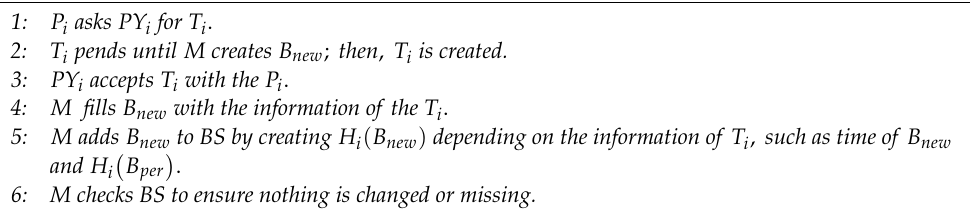
Algorithm 1 . Private medical blockchain